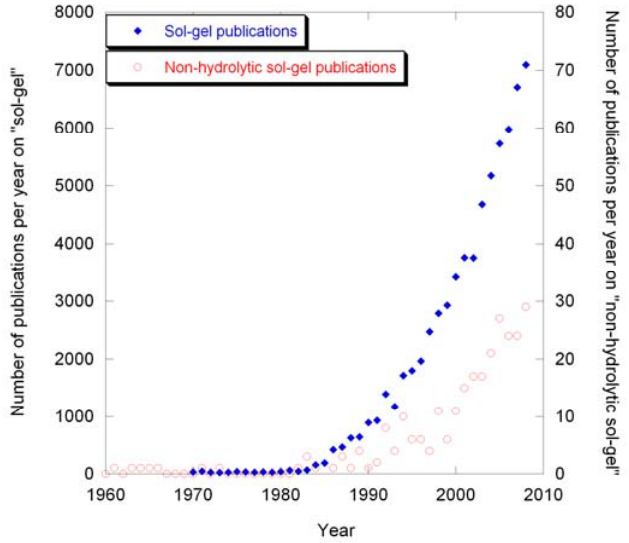
Figure 1. Number of publications per year on “sol-gel” and “non-hydrolytic